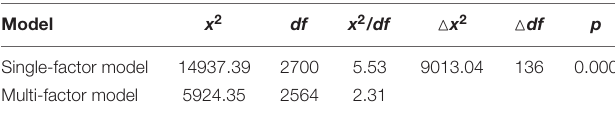
TABLE 5 | Comparison of multi-factor and single-factor models.